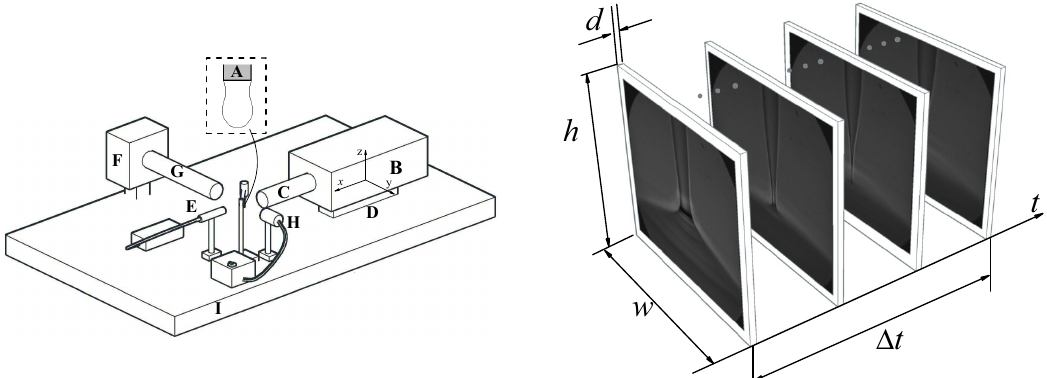
Figure 1. ( Left ) Experimental setup: feeding capillary (A), ultra-high speed video camera (B), optical lenses (C), triaxial translation stage (D), laser (E), optical trigger (F), optical lenses (G), optical fiber (H), and anti-vibration isolation system (I). ( Right ) Minimum spatio-temporal hypervolume analyzed in the experiment: image width w = 94 µ m, height h = 78 µ m, depth of field d = 0.48 µ m and time ∆ t = 36 µ s elapsed during the experiment.